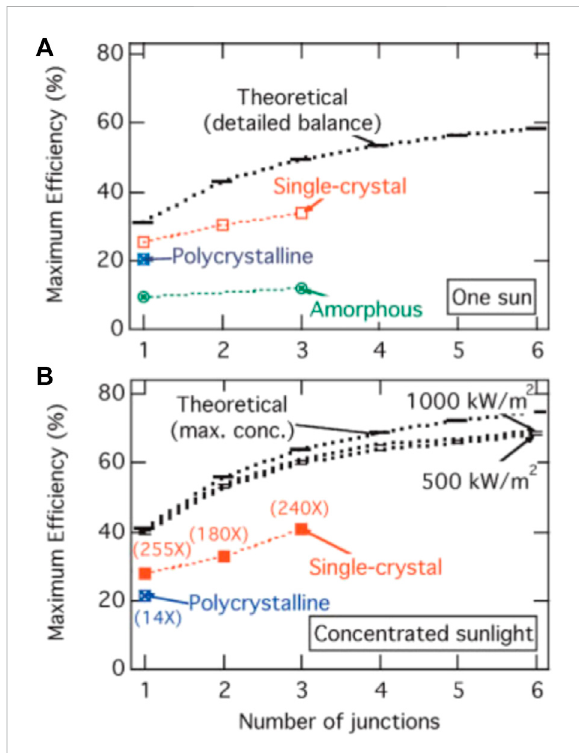
FIGURE 8 Theoretical and champion ef fi ciencies of multijunction solar cells under (A) one sun and (B) concentrated sunlight (Kurtz et al.,